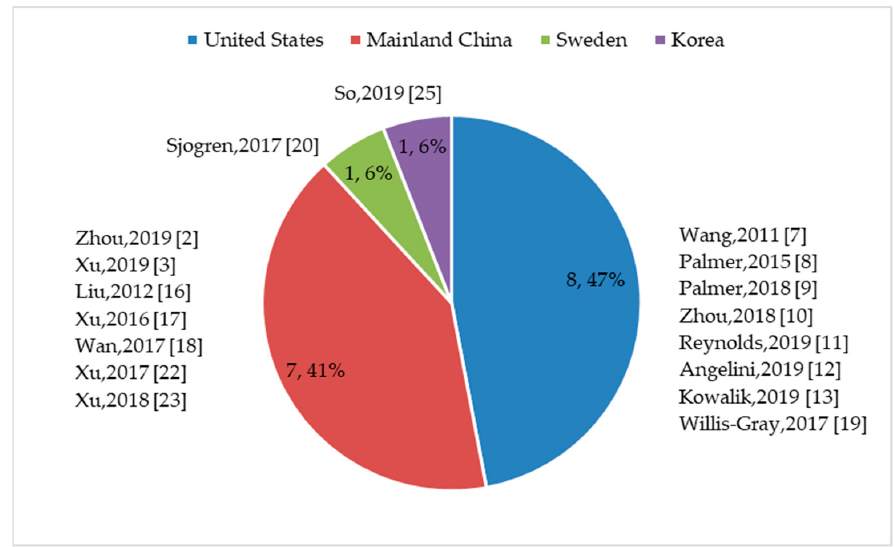
Figure 2. Numbers and percentages of studies where Toileting Behavior–Women’s Elimination Behaviors (TB–WEB scale was used, by country (n, %).